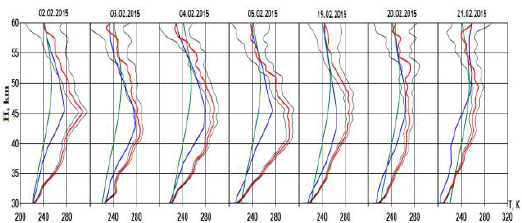
Figure 4 Lidar and satellite observations of the stratospheric warming in December 2014 and January 2015. Red lines show the Rayleigh lidar measurements, black line shows the standard deviation, blue line shows the AURA measurements, and green line shows the monthly mean profile according the CIRA-86 model